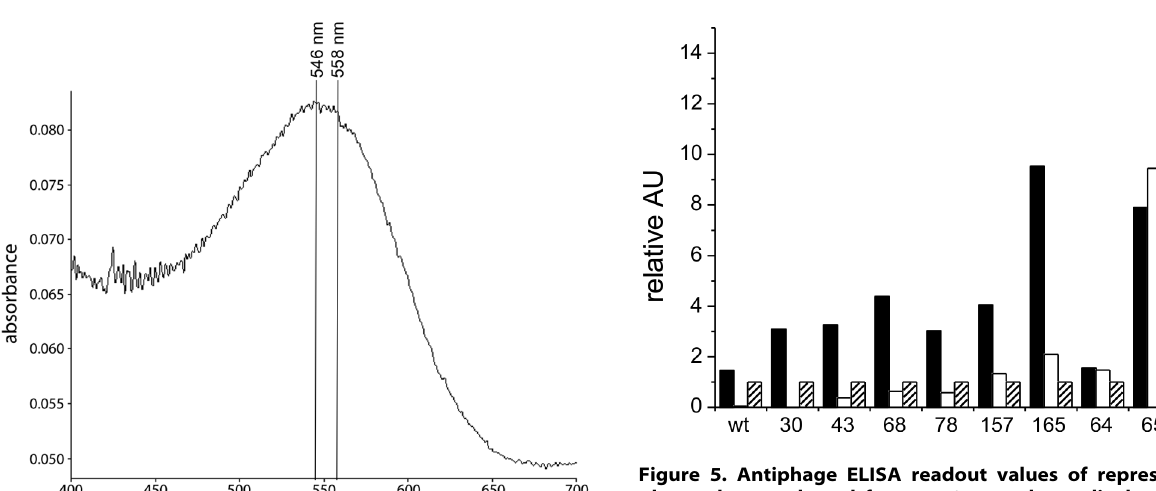
Figure 5. Antiphage ELISA readout values of representative phage clones selected from a 12-mer phage display peptide library. Solid bars indicate binding of the phage clone to bR loaded nanodiscs, open and hatched bars to wells of the micro titer plate that were loaded with empty nanodiscs or BSA, respectively. Readout values of the wells loaded with bR and empty nanodiscs were normalized to the well binding signal of each clone. Single determination was performed for each clone. Numbers below the bars refer to the given ID numbers of each phage clone. Wild type (wt) refers to phage displaying no